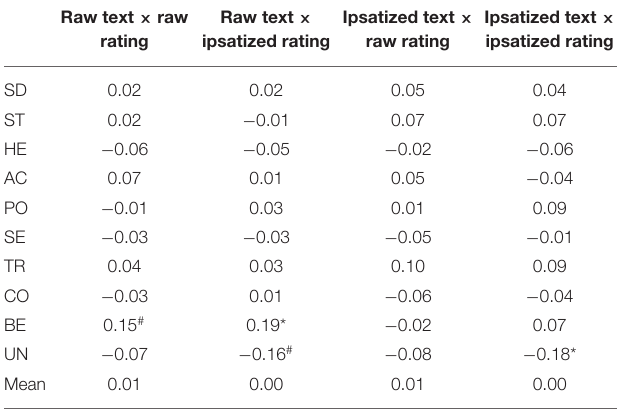
TABLE 10 | Correlations between motivationally matched value types in Study 3. Raw text × raw